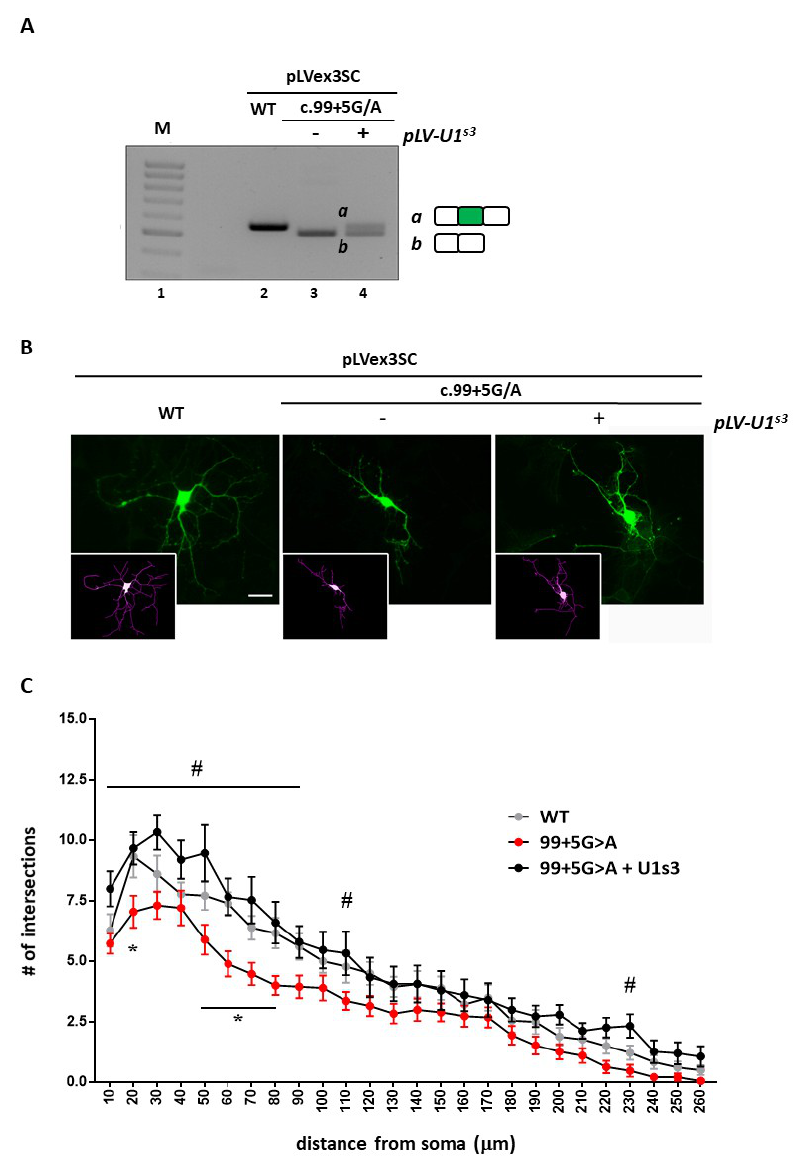
Figure 6. U1 s3 snRNA rescues the dendritic morphology of Cdkl5 null hippocampal neurons. ( A ) RT-PCR analysis of CDKL5 splicing in hippocampal WT neurons infected at DIV1 with lentiviruses expressing either the WT (pLLSC-CDKL5WT) or the mutant pLLSC-CDKL599 + 5A (c.99 + 5G > A) cDNA alone or in combination with lentiviruses expressing ExSpeU1 S3 (pLV-U1 s3 ). ( B ) Representative immunofluorescences of GFP positive Cdkl5 null neurons (in green) and the corresponding masks (in violet) are reported. Neurons were infected at DIV1 with the WT or the mutant pLLSC-CDKL599 + 5A construct alone or in combination with viruses expressing ExSpeU1 S3 , and morphologically analyzed by Sholl analysis plug-in. Scale bar 20 µ m. ( C ) The graph shows the mean ± SEM of the numbers of intersections of neurons of each experimental group. Data were analyzed by two-way ANOVA, followed by Tukey’s multiple comparison test. * p < 0.05 indicates a significant difference between c.99 + 5G > A and WT vector infected neurons; # p < 0.05 indicates a significant difference between c.99 + 5G > A and c.99 + 5G > A + pLV-U1 s3 .